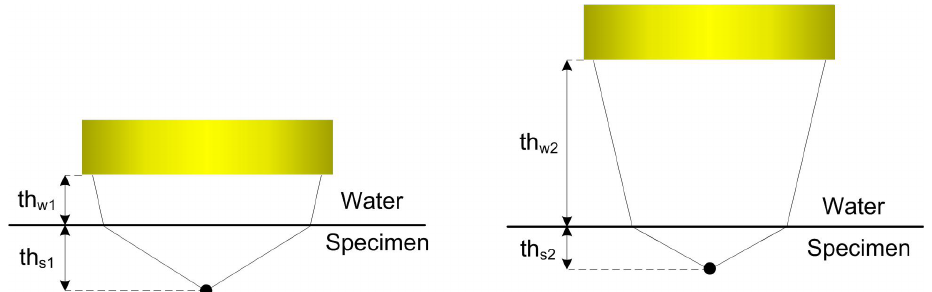
Figure 1. Principle of focused field control in conventional automatic ultrasonic